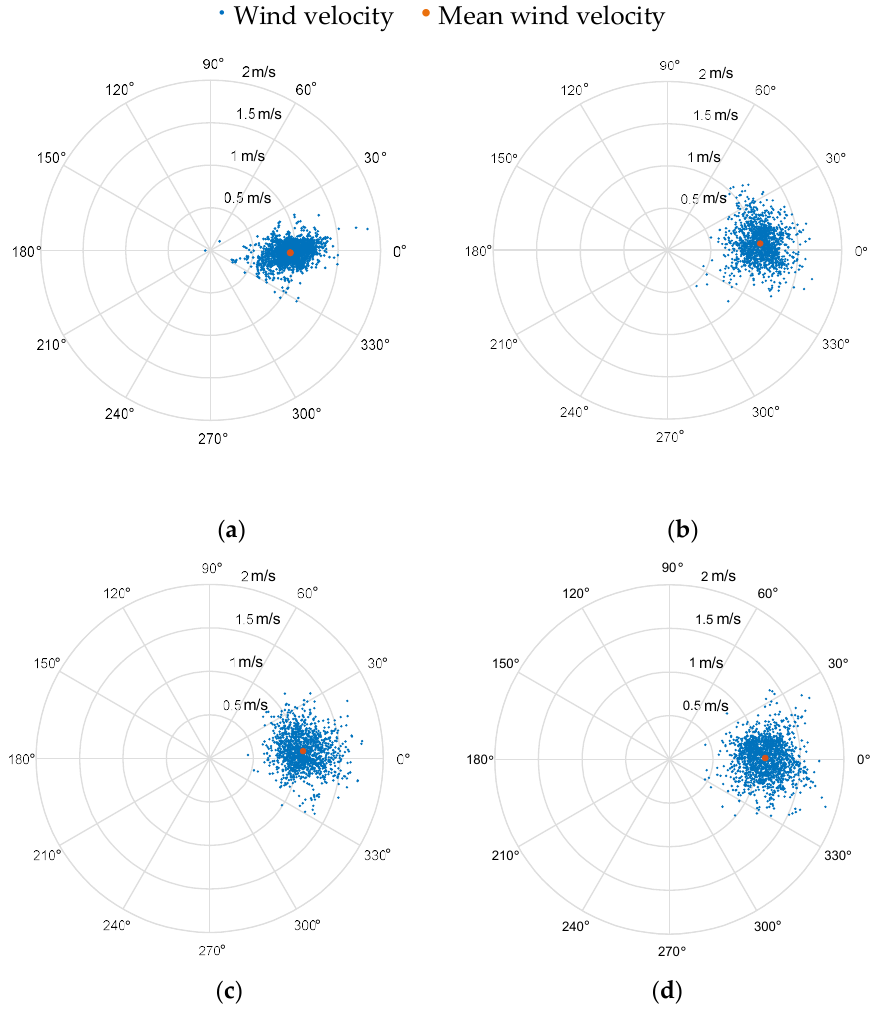
Figure 15. Estimation results by the quadrotor. ( a ) is the estimation result by the quadrotor in hovering condition. ( b – d ) are three sets of the estimation results by the quadrotor in flight condition. Table 4. Measurement results of the anemometers.